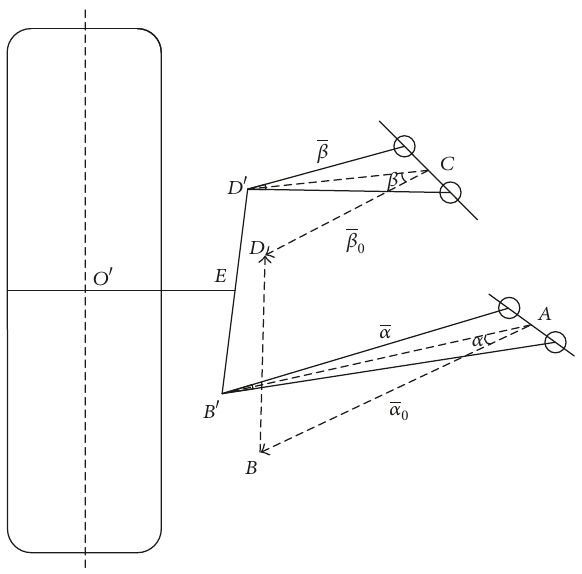
Figure 2: Structure diagram of double suspension arm.